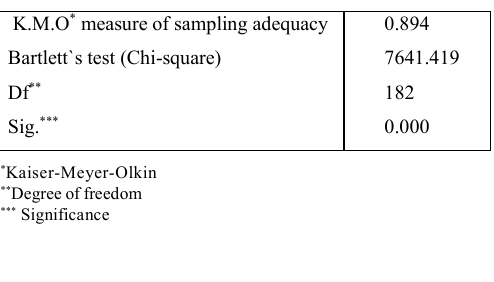
Table 1: KMO and Bartlett’s Test (Bartlett,